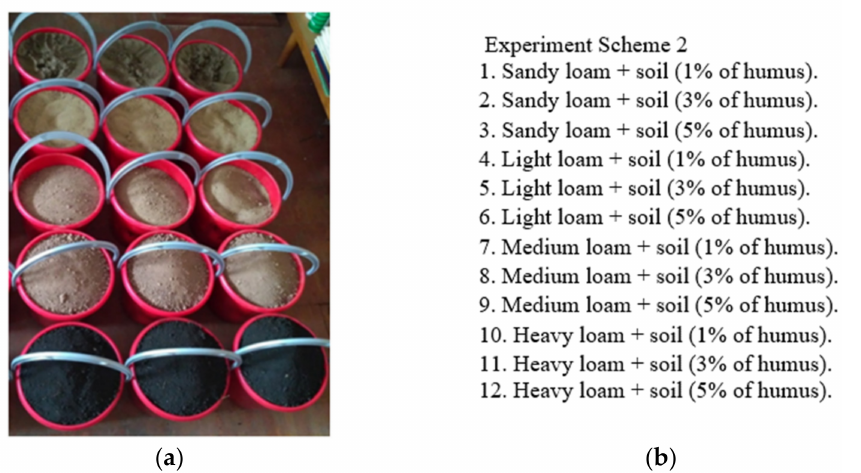
Figure 1. Standard soils: ( a ) view of vessels containing basic soil substrates, ( b ) the experiment scheme based on the basic soil